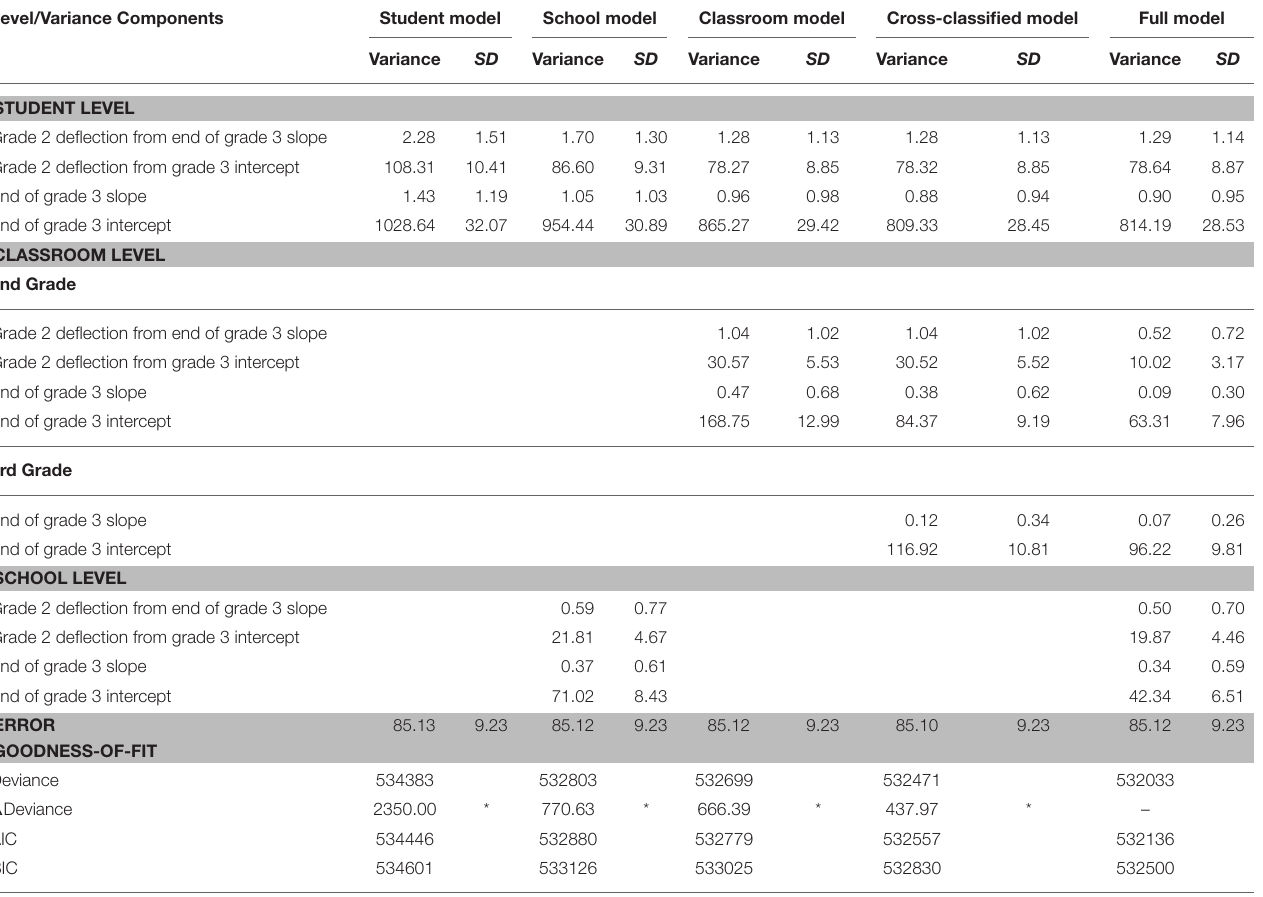
TABLE 6 | Estimates of random parameters for growth models ( N =